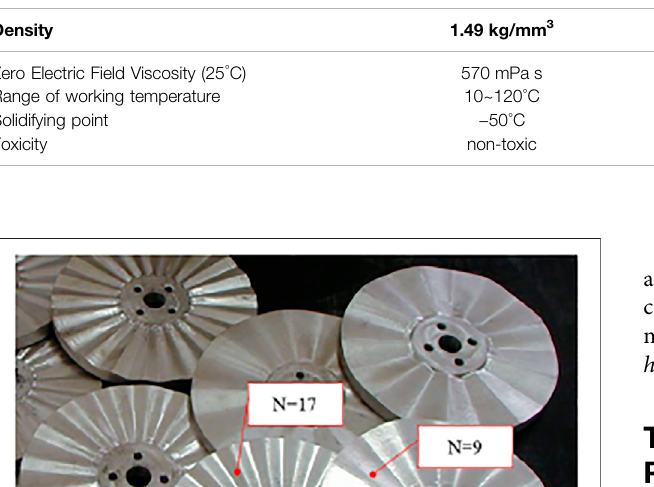
TABLE 1 | Characteristics of HITL2 ER fl uids.